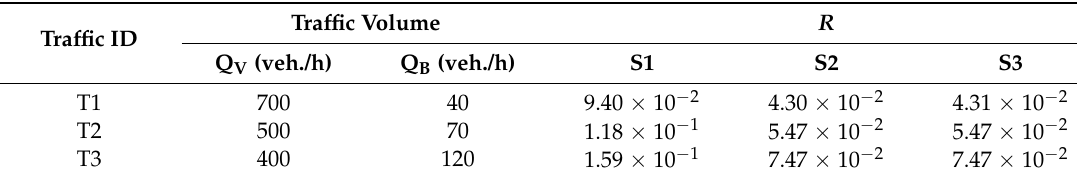
Table 7. Risk analyses for different traffic